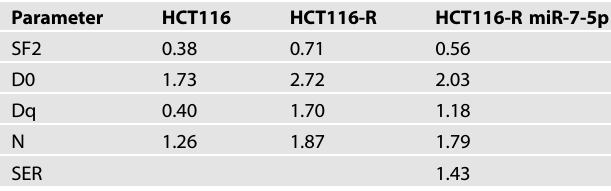
Table 1. The radiosensitive parameters of HCT116, HCT116-R and miR- 7-5p-overexpressing HCT116-R cells.